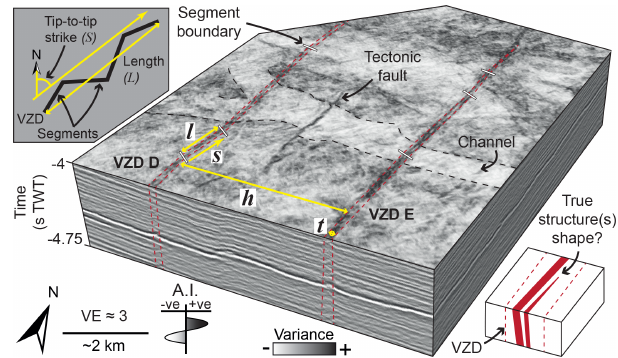
Figure 5. Interpreted 3D view of vertically exaggerated (VE) seis- mic reflection data, which images parts of VZDs D and E and high- lights recorded measurements: t = VZD thickness; h = VZD spac- ing; s = VZD segment strike; l = VZD segment length (see Fig. S3 for uninterpreted version). Note the channel on the plan-view vari- ance time slice is not laterally offset where it is cross-cut by the VZDs. Depth shown in seconds two-way travel time (s TWT). See Fig. 4c for location. Inset top-left: plan-view sketch depicting the tip-to-tip length ( L ) and strike ( S ) measurements for an entire VZD. Inset bottom-right: schematic diagram showing how a VZD’s ge- ometry may not correspond to the true shape of the structure, or structures, it